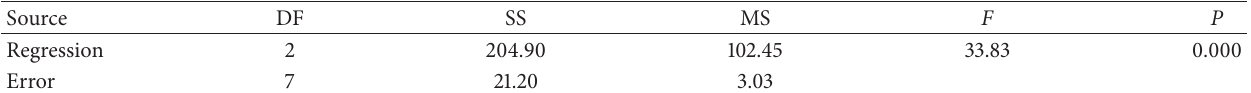
Table 12: Analysis of variance on the V-Funnel